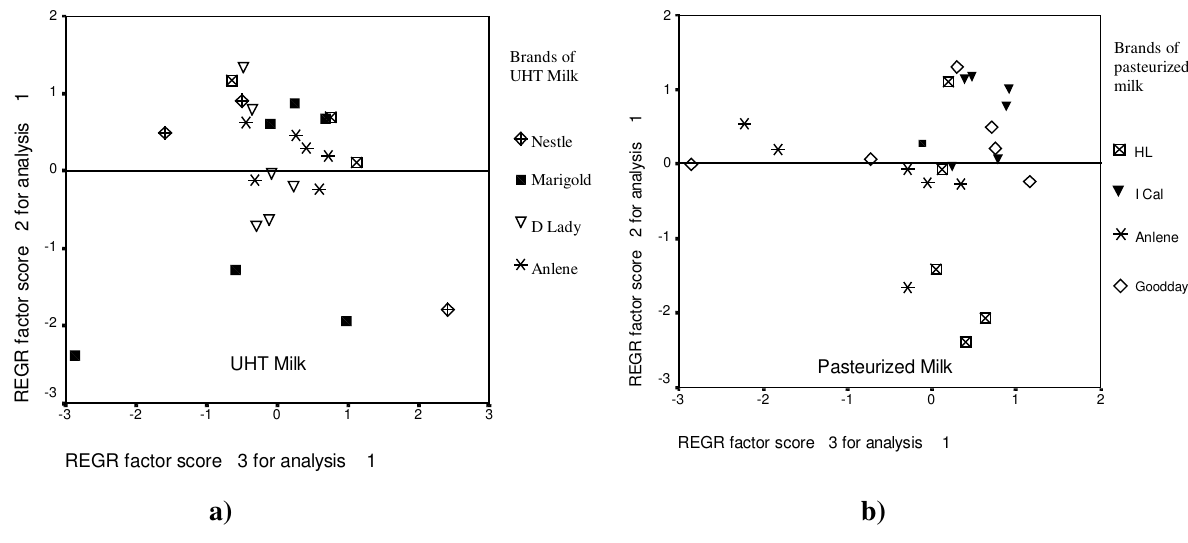
Figure 5. ‘Score plots’ of a principal component analysis with the second principle component vs the third principle component for fresh-spoiled (a) UHT and (b) pasteurized milk data.